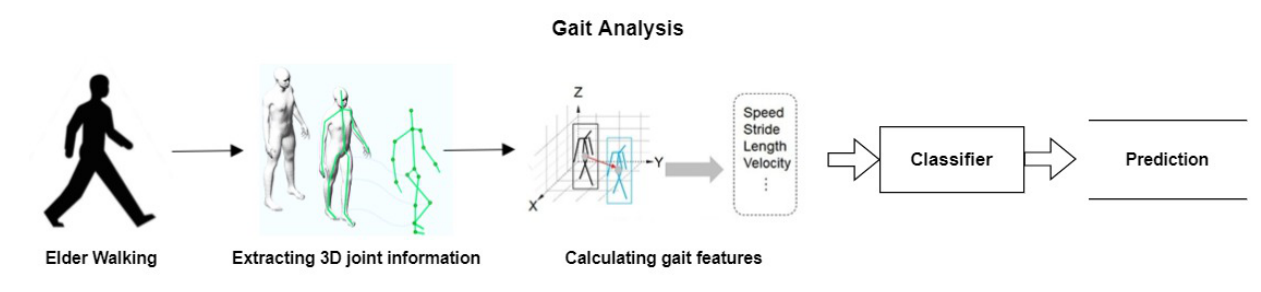
Figure 3. Gait analysis